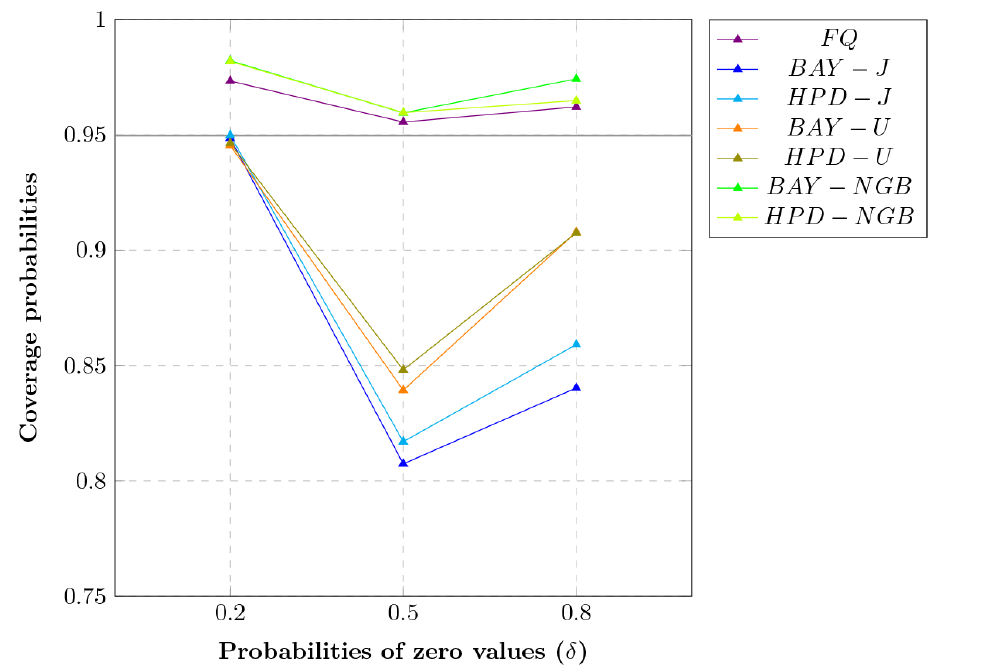
Figure 3. Line graphs of the CPs of the methods in the simulated scenario with different probabilities of zero values.